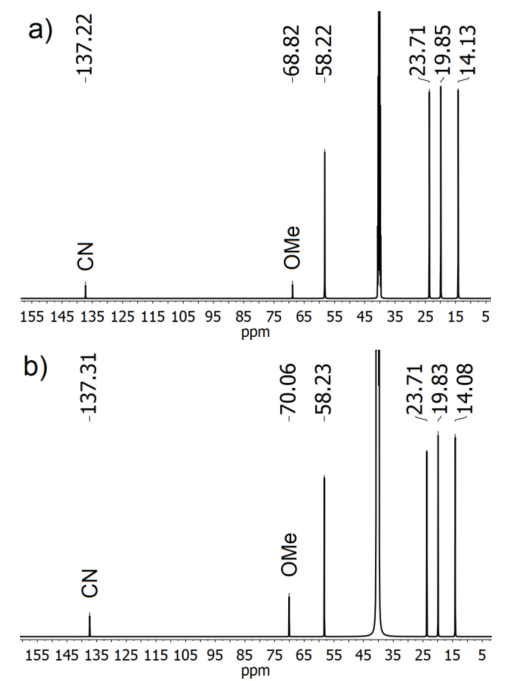
Figure 2. Experimental 13 C-NMR spectra for compounds 4 ( a ) and 5 ( b ) in DMSO-d 6